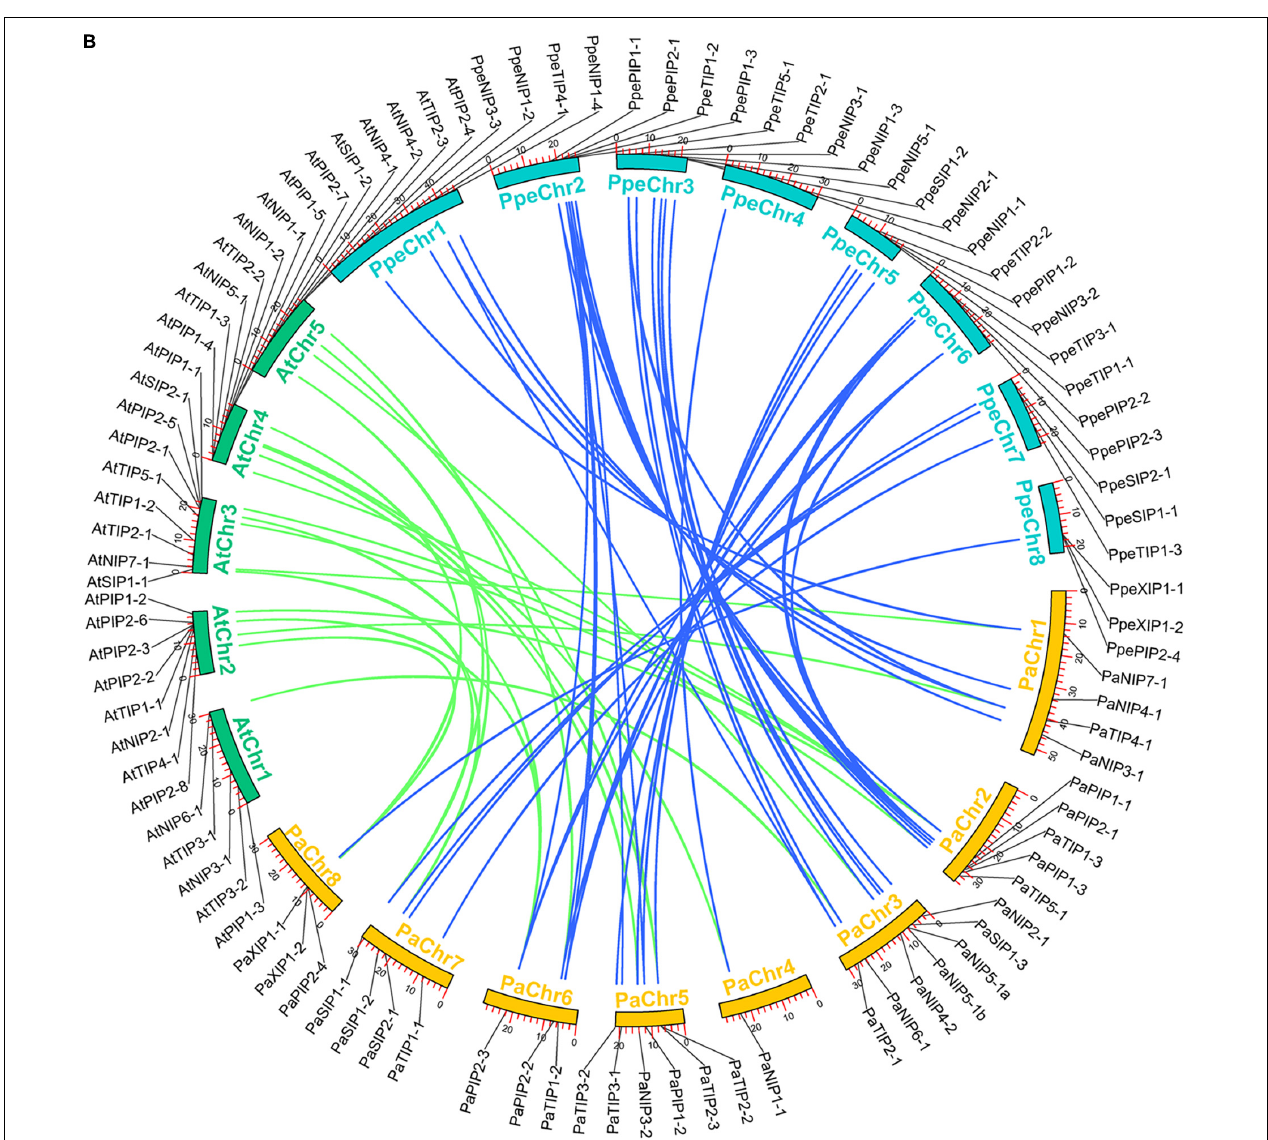
FIGURE 1 | Phylogenetic relationships and microsynteny analyses of AQP genes among the P. armeniaca , A. thaliana , and P . persica genomes. (A) Deduced amino acid sequences were aligned using default parameters in ClustalW, and the phylogenetic tree was constructed via the maximum likely hood method with 1,000 bootstrap replicates with MEGA 7.0 software. Red, green, and blue circles represent the A. thaliana , P. armeniaca , and P . persica AQP gene family members. Yellow, blue, red, orange, and green arches represent the SIP , XIP , NIP , PIP, and TIP AQP gene family subgroups of A. thaliana , P. armeniaca , and P . persica . The scale bar indicates the distance calculated by way of multiple alignment. (B) The chromosome numbers of all three species are specified by different colors: blue, green, and yellow represent the P. armeniaca , A. thaliana , and P . persica chromosomes, respectively. The chromosome number is indicated on the inside with the chromosome sequence lengths in megabases. Gene pairs with syntenic relationships are linked by blue and green lines representing the microsyntenic regions between the P. armeniaca and A. thaliana chromosomes and the P. armeniaca and P . persica chromosomes, respectively.